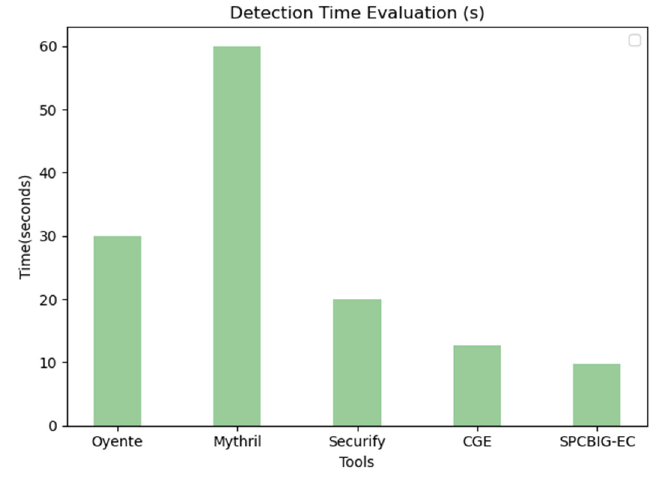
Figure 12. The comparison in detection time.